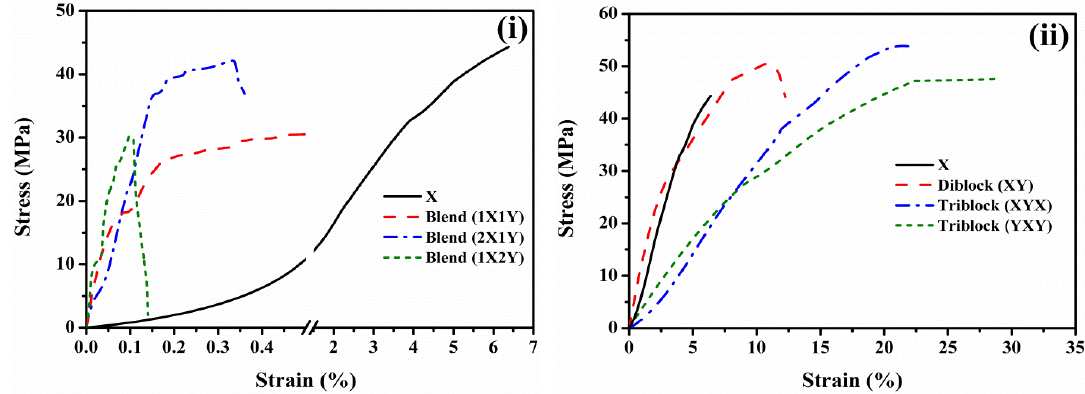
Figure 8. UTM stress-strain curves of ( i ) blend and ( ii ) block copolymer membranes.